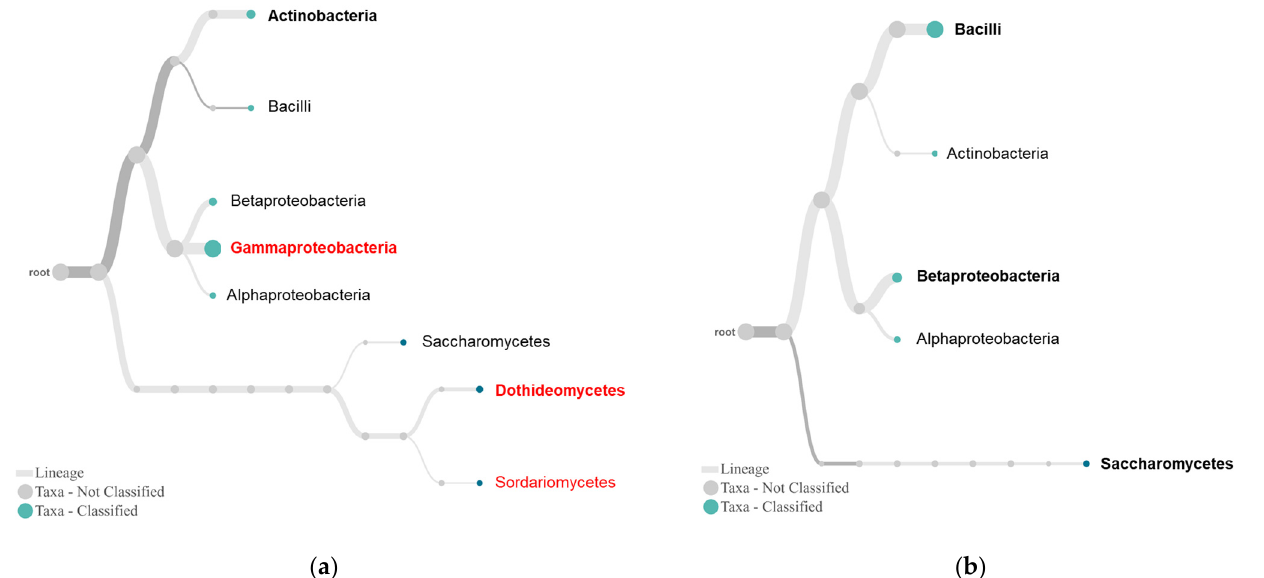
Figure 4. Endophytes in susceptible RfB ( a ) and tolerant VbM ( b ) plants. By default, the trees were constructed with WIMP presenting the top 30 taxa at abundance >1% and a taxonomic rank of class. Taxonomic lineages in bold are predominant in the samples, and those in color are unique to the plant group.